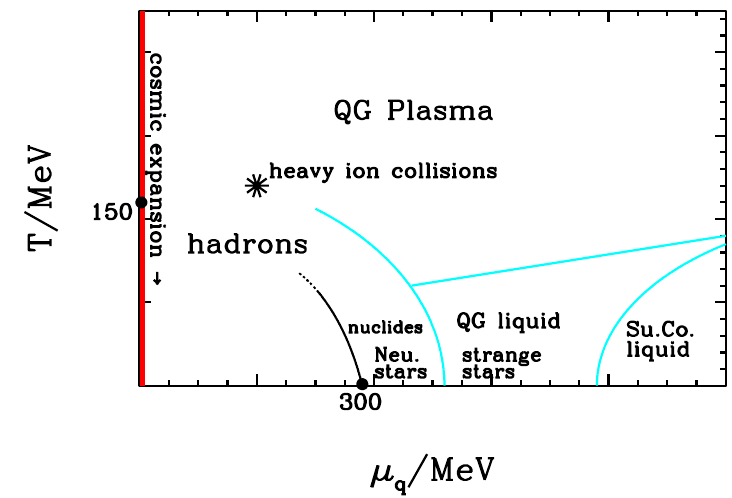
Figure 1. A scheme of s.i. matter states and transition lines; the red vertical line at the extreme left shows the track of cosmological evolution, quite far from any other relevant area. We expect a phase transition to occur along the black curve. Any suggested phase transitions across other curves in cyan are hypothetical; the very existence of a QG liquid and of its superconducting phase is hypothetical [11]. µ q is the chemical potential associated to B /3, the baryon number in